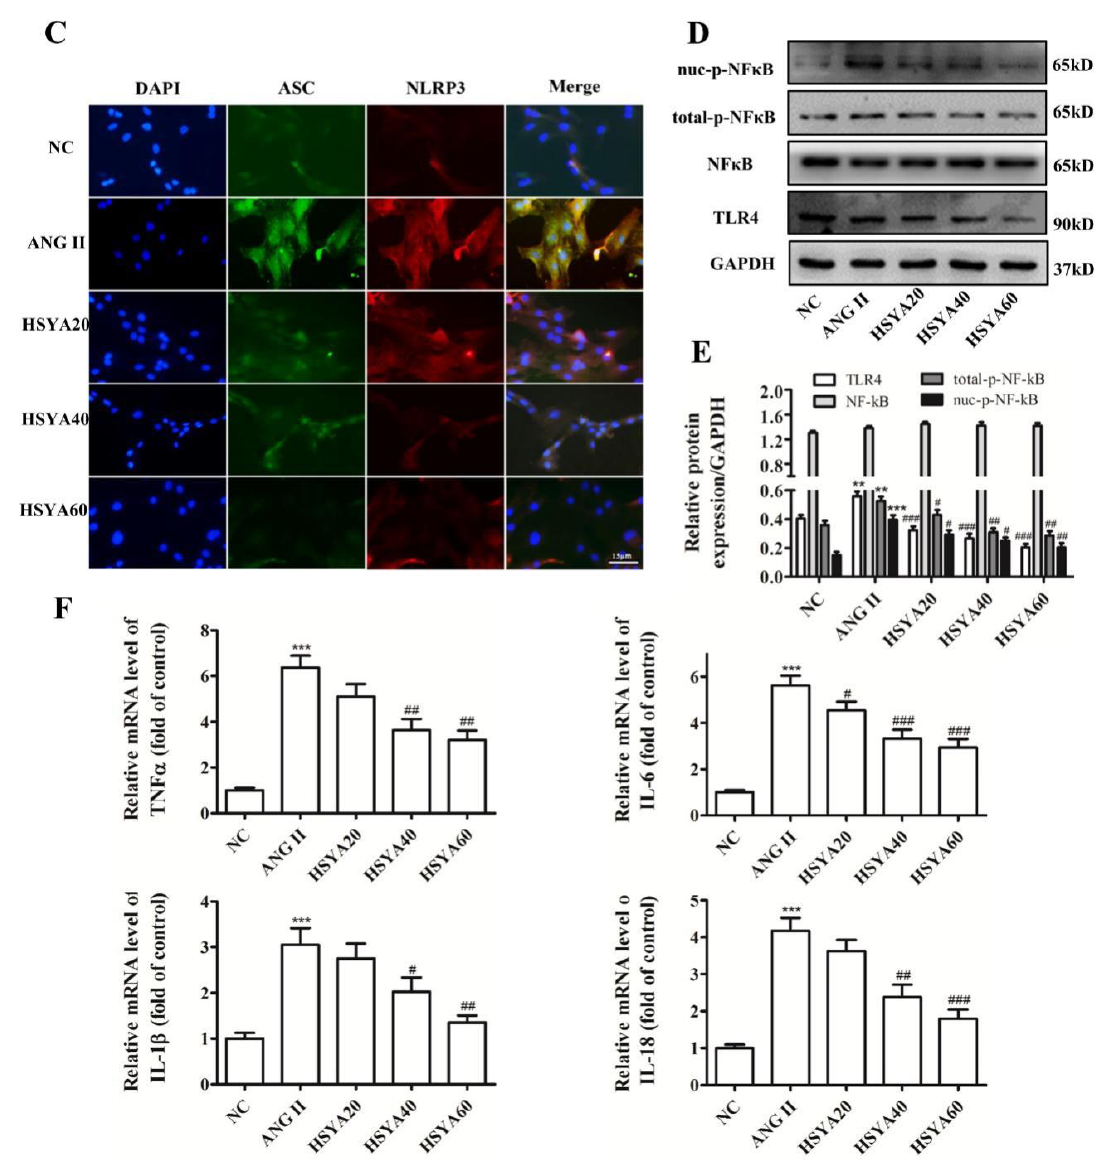
Figure 2. HSYA inhibits NLRP3 inflammasome activity through the TLR4/NF- κ B signaling pathway. ( A ) The expressions of NLRP3 inflammasome-related proteins analyzed via Western blot. ( B ) The quantification of the protein blots in ( A ). ( C ) NLRP3 (red) and ASC (green) protein expression in VAFs ( n = 3). Scale bar, 15 µm. ( D ) Western-blot analysis of the expression of TLR4/NF- κB -related proteins treated with ANG II and HSYA ( n = 3). ( E ) The quantification of the protein blots in ( D ). ( F ) mRNA levels of IL-6, TNF α , IL-1 β , and IL-18 in the five VAF groups were determined via quantitative real-time PCR. * Compared with the NC group, # compared with the ANG II group, # p < 0.05, ## p < 0.01, *** / ### p < 0.001.